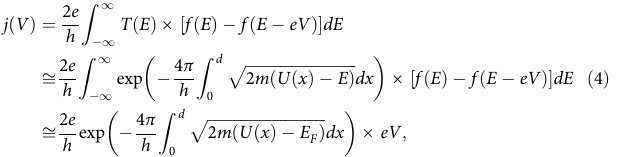
ffiffiffiffiffiffiffiffiffiffiffiffiffiffiffiffiffiffiffiffiffiffiffiffiffiffiffiffiffi p 2 m ð U ð x Þ (cid:2) E Þ ffiffiffiffiffiffiffiffiffiffiffiffiffiffiffiffiffiffiffiffiffiffiffiffiffiffiffiffiffiffiffi 2 m ð U ð x Þ (cid:2) E F Þ